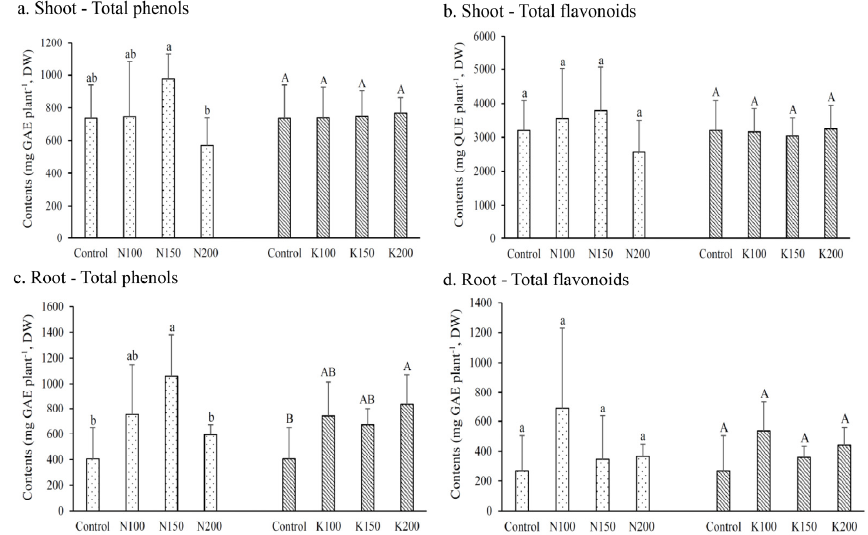
Figure 4. Effects of different fertilizer treatments on the contents of total phenol and total flavonoid contents in the field cultivated C. taiwanianum . Values are mean ± standard deviation ( n = 4). The bars with different letters within the same fertilizer treatment (N treatments: Control, N100, N150 and N200; K treatments: Control, K100, K150 and K200) are significantly different ( p < 0.05, LSD tests). Table 1. Effects of different fertilization treatments on concentrations of polyphenolic compounds in shoots and roots of field-cultivated C. taiwanianum .